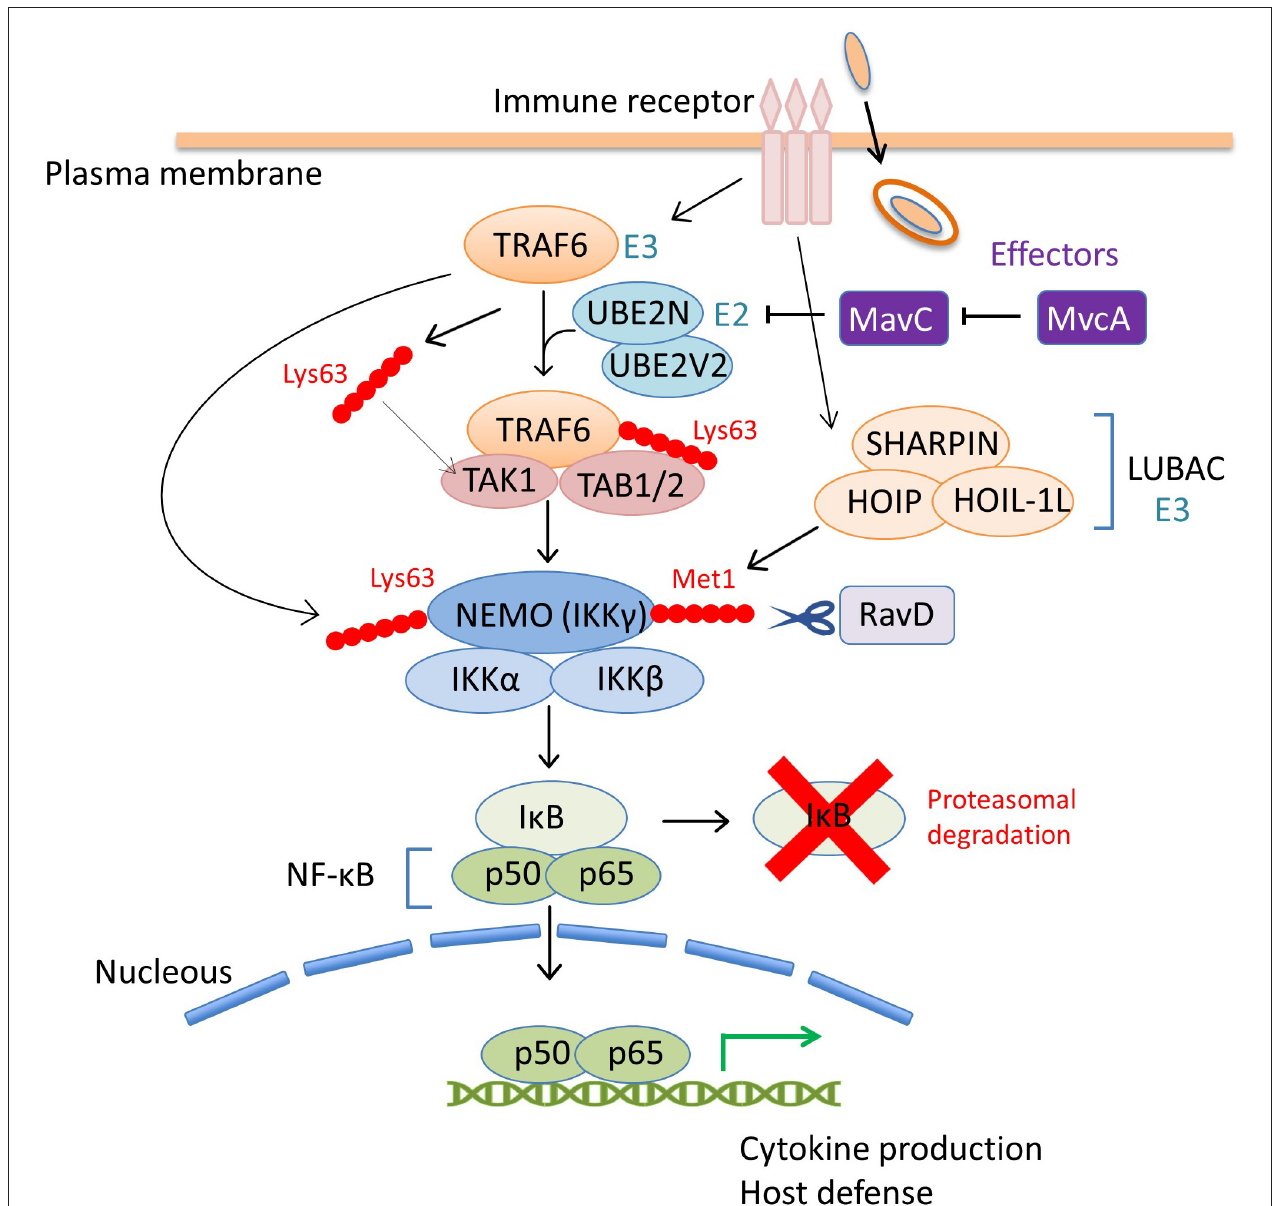
FIGURE 3 | The coordinated regulation of the host NF- κ B pathway by L . pneumophila effectors via ubiquitin modulation. Upon bacterial infection, the NF- κ B family of transcription factors play a central role in controlling the host immune response, such as the production of proinflammatory cytokines, including tumor necrosis factor α (TNF α ) and interleukin-1 (IL-1) and the induction of host defense signaling (Li and Verma, 2002). The inhibitor of NF- κ B (I κ B) suppresses the activity of NF- κ B by binding and preventing nuclear translocation. The NF- κ B pathway is mainly mediated by the engagement of host immune receptors that can recognize pathogen-associated molecular pattern molecules of extracellular or intracellular bacteria. One of the downstream pathways in which TNF α -receptor-associated factor 6 (TRAF6) is involved, is modulated by a L . pneumophila effector, MavC. TRAF6 is an E3 ubiquitin ligase that functions with the E2 enzyme hetero-dimer complex UBE2N/UBE2V2 (also known as Ubc13/Uev1A) to induce its auto-polyubiquitination and polyubiquitination of other neighboring proteins via Lys63-linked ubiquitin chains (Wang et al., 2012). The Lys63-linked ubiquitin chains of TRAF6 serve as docking sites for TGF- β -activated kinase 1 (TAK1)-binding protein 2 (TAB2). TAB1 and TAB2 promote the recruitment of the serine-threonine kinase TAK1 into the complex to activate the pathway. Activated TAK1 phosphorylates I κ B kinase β (IKK β ) to promote the proteasomal degradation of I κ B, thereby allowing NF- κ B nuclear translocation. TRAF6-mediated Lys63-linked ubiquitin chains are associated with the NF- κ B essential modifier (NEMO, also known as IKK γ ) in the IKK α /IKK β /NEMO complex and play a crucial role in IKK signaling. TRAF6 also produces free Lys63-linked polyubiquitin chains, which directly activate TAK1 kinase by binding to TAB2. In this scheme, the inhibitory activity of MavC against UBE2N dampens the NF- κ B signaling pathway (including many other signaling branches not shown in this figure) by preventing overall Lys63-linked ubiquitination. MvcA, the metaeffector of MavC, can counteract the activity of MavC in the later stage of infection, presumably to restore cellular conditions that optimize bacterial replication. RavD, the other L . pneumophila effector, functions as a DUB, and contributes to negative regulation of NF- κ B signaling. The host multi-subunit E3 ligase LUBAC, composed of